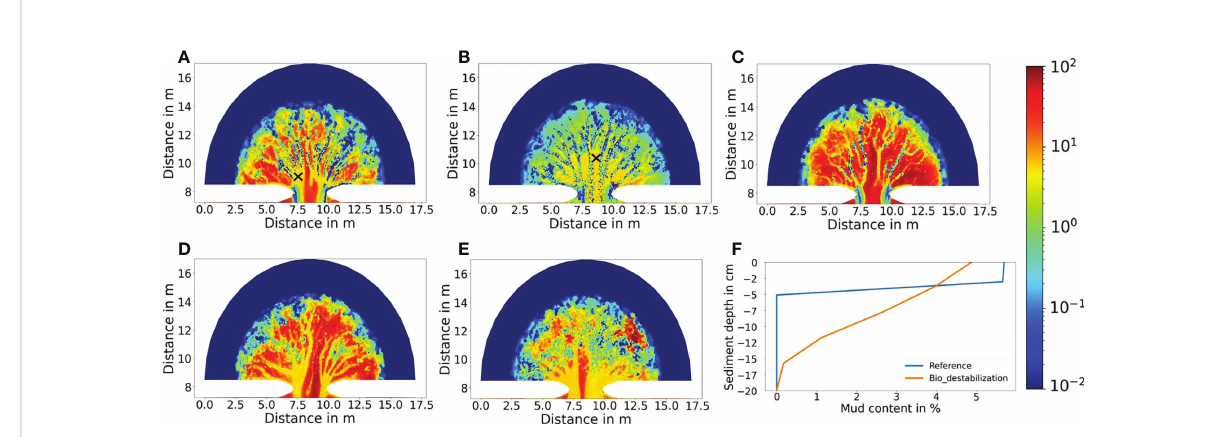
FIGURE 7 Simulated mud content (in percentage) at year 500 for the (A) Reference result, (B) the Bio_destabilization scenario, (C) the Bio_stabilization scenario, (D) the Bio_deposition scenario and (E) the Bio_all scenario. (F) Comparison of typical vertical pro fi le of mud content in sea fl oor sediment at tidal fl ats between the reference result (exclusion of benthic faunal impact) and the Bio_destabilization scenario (inclusion of bio- mixing). Locations of the sites are indicted by X mark in (A) and (B) ,